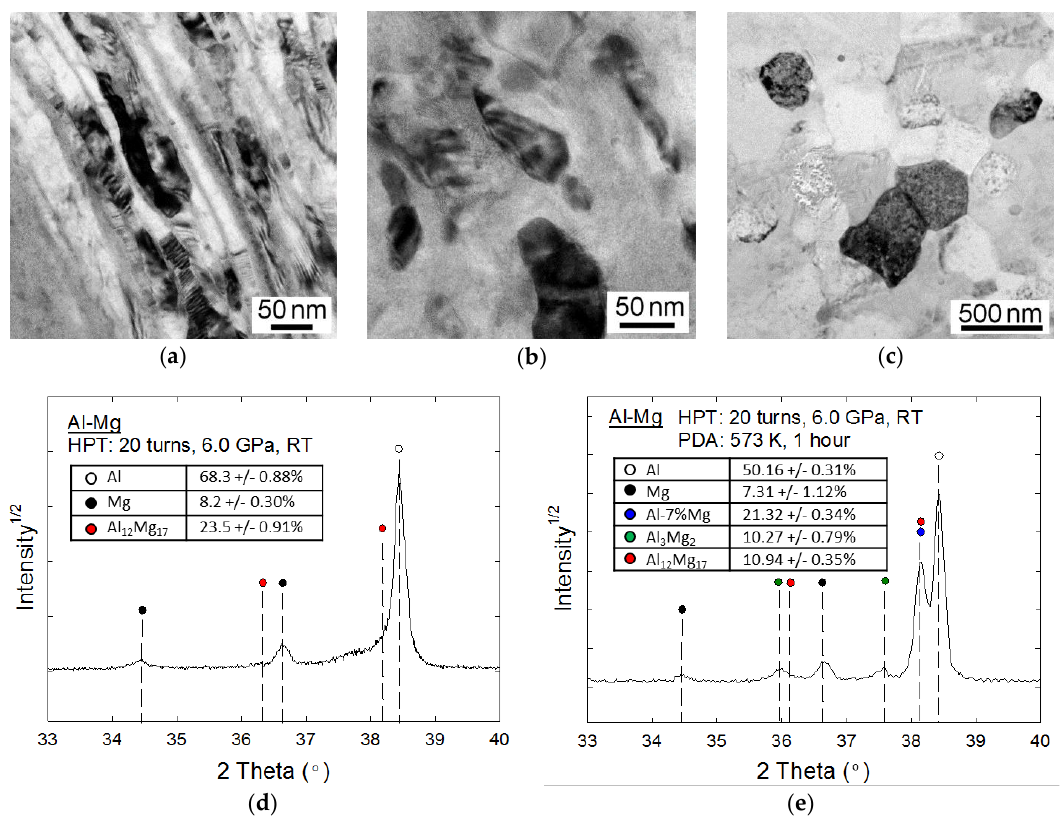
Figure 3. Representative TEM bright-field images taken at the disk edges after ( a – b ) HPT for 20 turns and ( c ) HPT followed by PDA in the Al-Mg system and the X-ray diffraction profiles for the disk edges of the Al-Mg system after ( d ) HPT for 20 turns and ( e ) HPT and PDA [37].